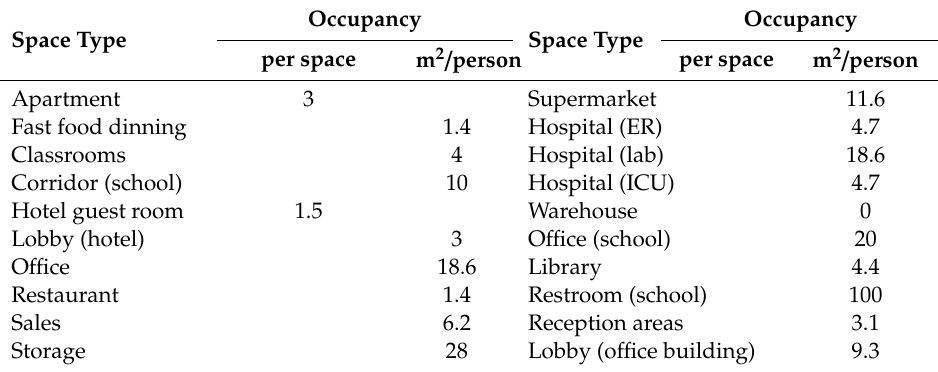
Table 2. Occupancy by space type